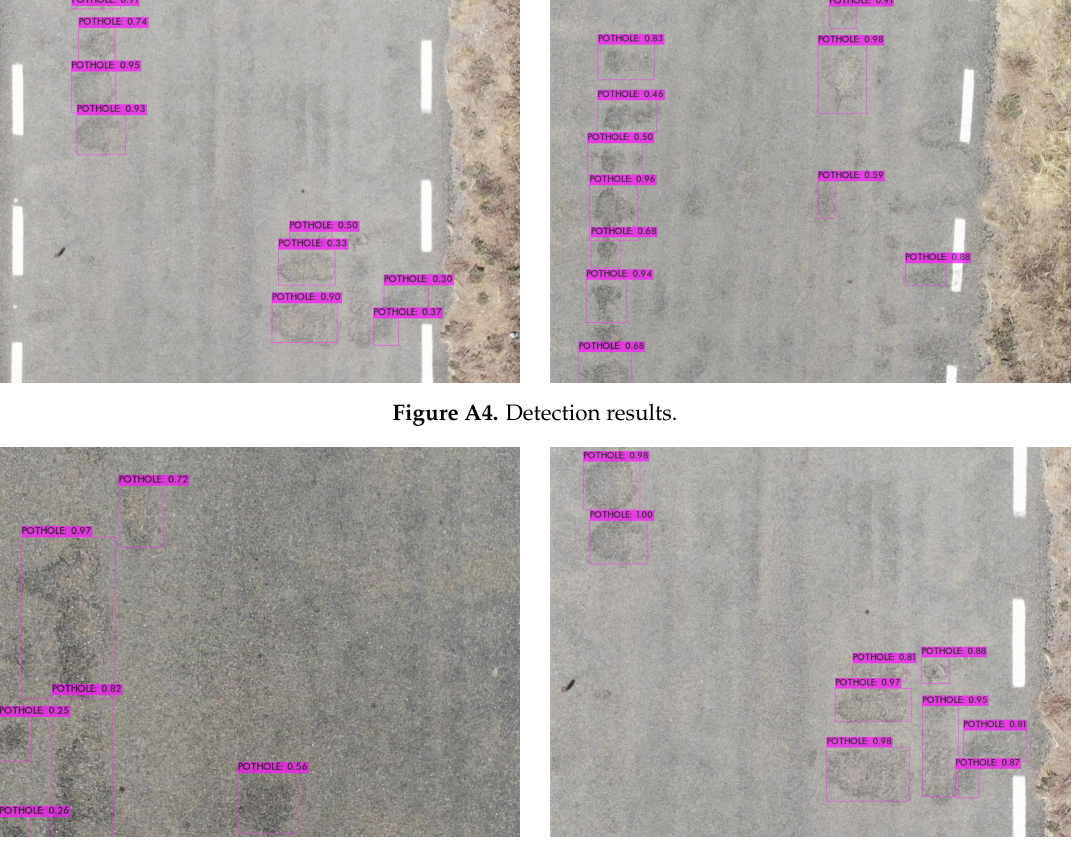
Figure A5. Detection